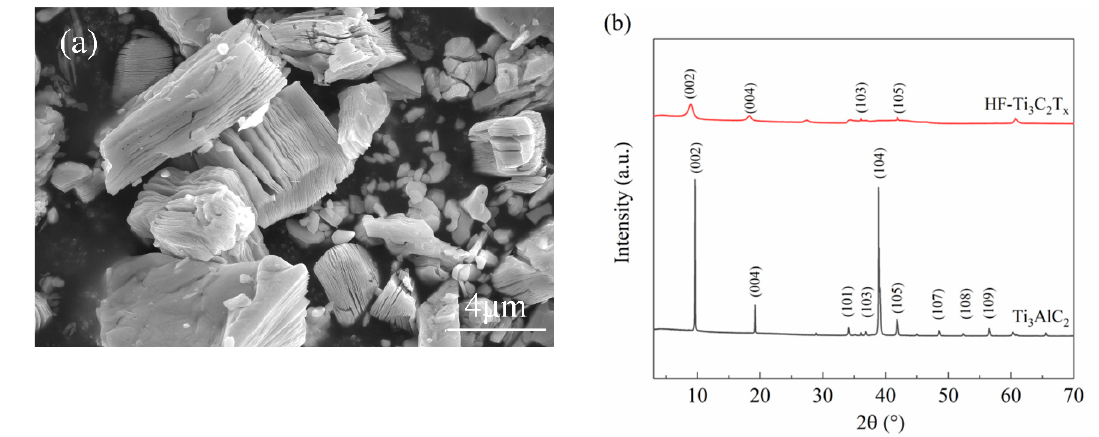
Figure 1. Characterization of HF-Ti 3 C 2 T x fillers, ( a ) SEM image, ( b ) XRD patterns.